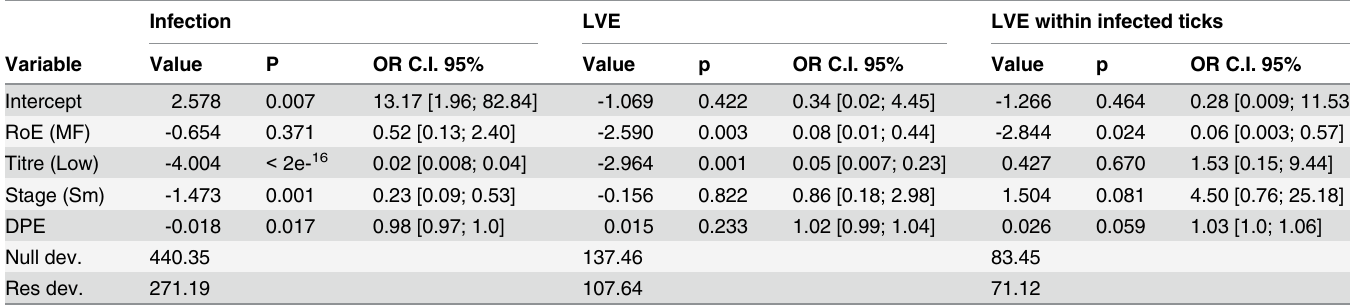
Legend: RoE — Route of exposure; (MF) — membrane feeding; (Low) — low titre of virus exposure; (Sm) — small nymphal stages, n4-n1; DPE — days post